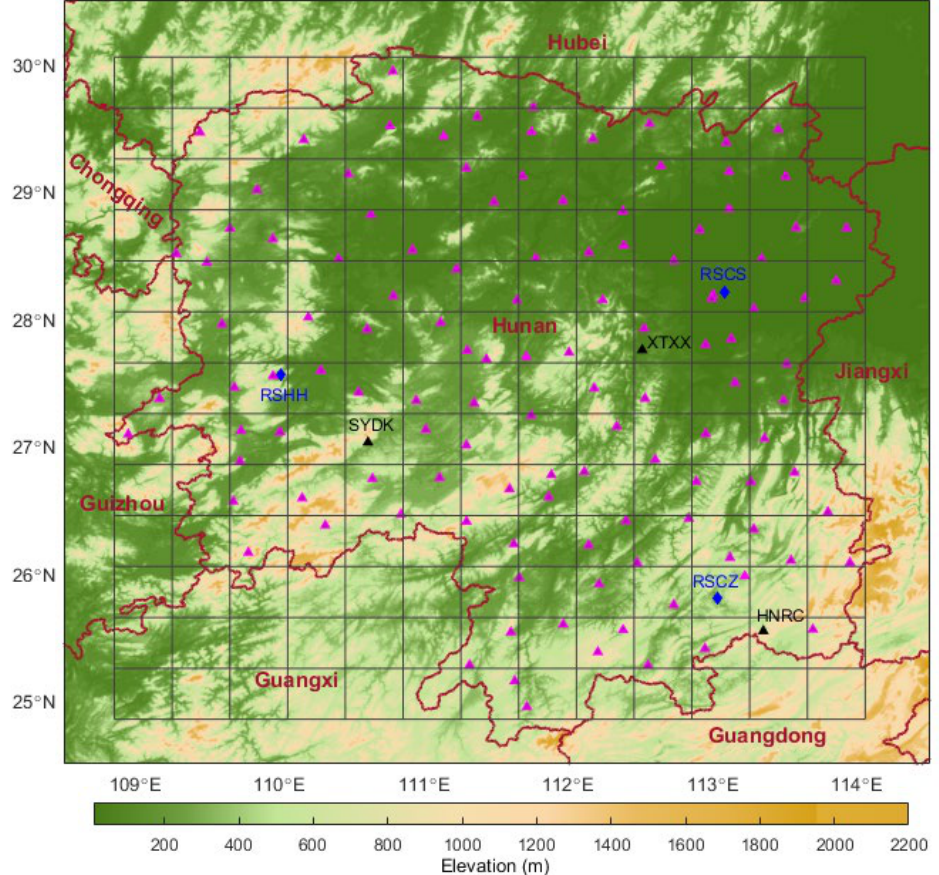
Figure 2. Geographic distribution of global positioning system (GPS) (triangles) and radiosonde (blue diamonds) stations in Hunan Province, China. The black triangles represent the GPS stations used for self-validation. The gray grids indicate the voxel discretization in the horizontal directions. The tomographic region covered from 108.85°E–114.05°E in longitude and 24.85°N–30.05°N in latitude. Radiosonde profiles revealed that wet refractivities approached zero at the altitude of 11 km. Therefore, the selection of 11 km as the top boundary of the tomographic region in Hunan and